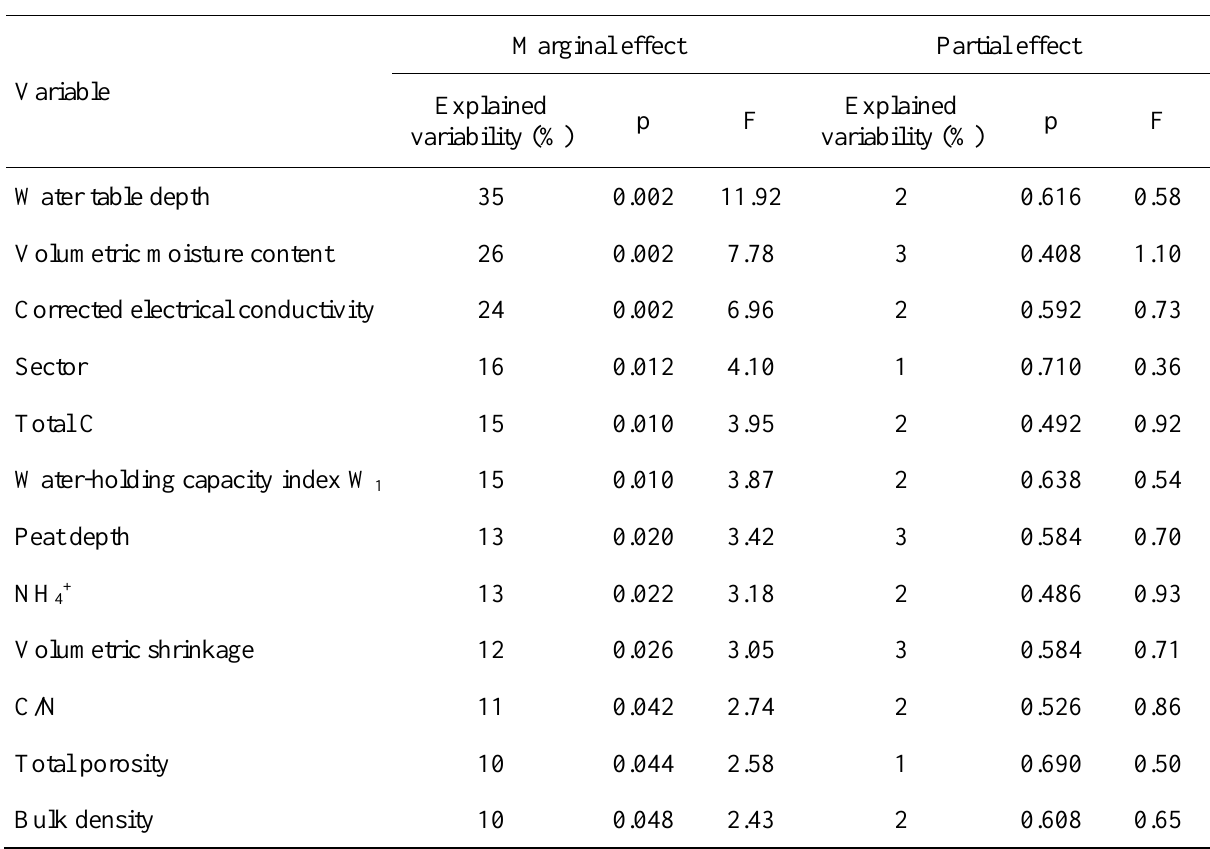
Table 4. Results of the constrained ordination (RDA). Marginal effects of the environmental variables and their partial effects on the vegetation based on forward selection (Monte Carlo permutation test). Only variables with significant marginal effect are